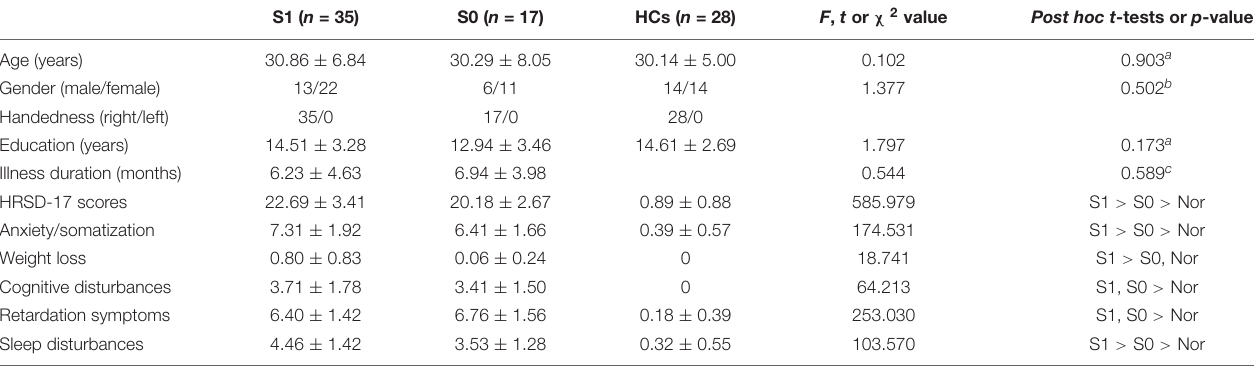
TABLE 1 | Demographic and clinical characteristics of the participants.